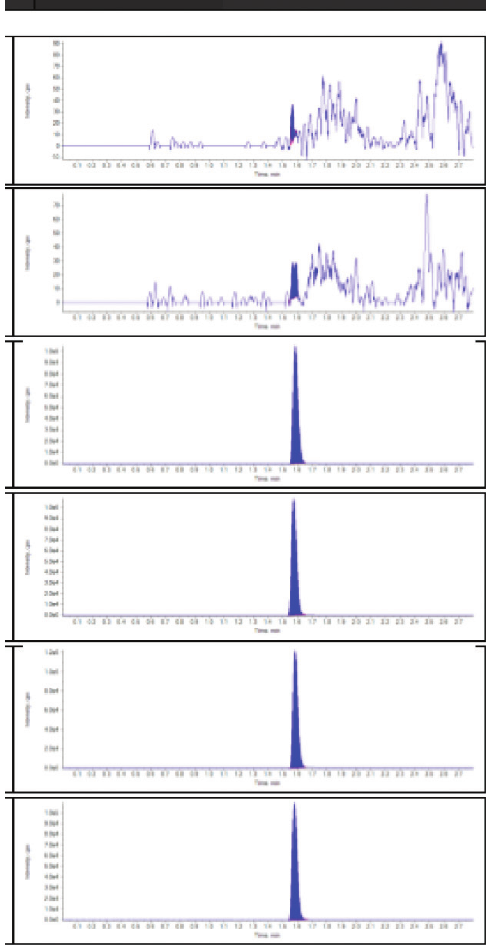
Figure 2. Typical multiple reaction monitoring chromatograms of